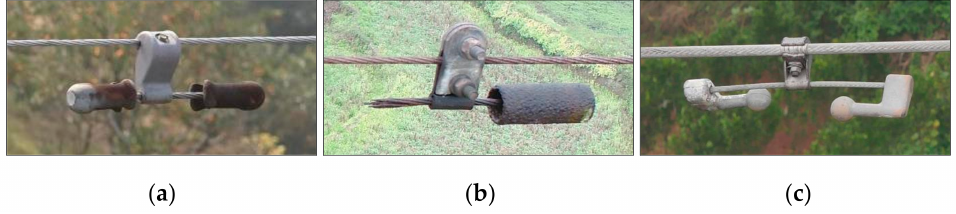
Figure 3. Three common states of vibration dampers: ( a ) rusty; ( b ) defective; ( c )